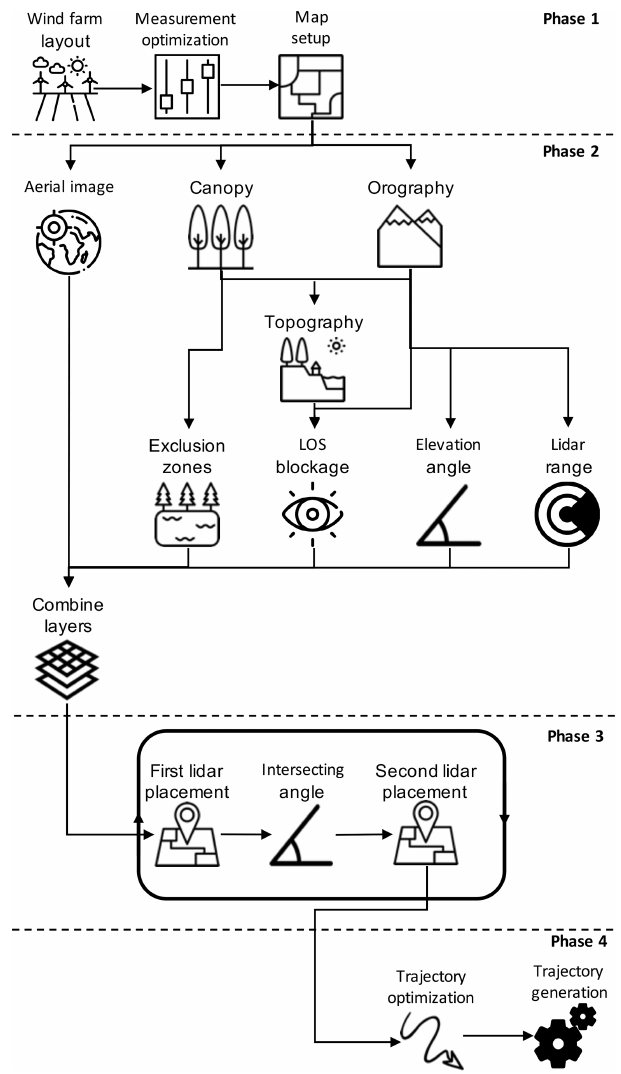
Figure 1. Campaign planning workflow (figure designed using © freepik.com icon